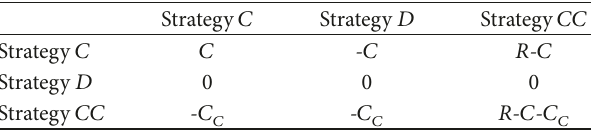
Table 2: Profit matrix of incentive